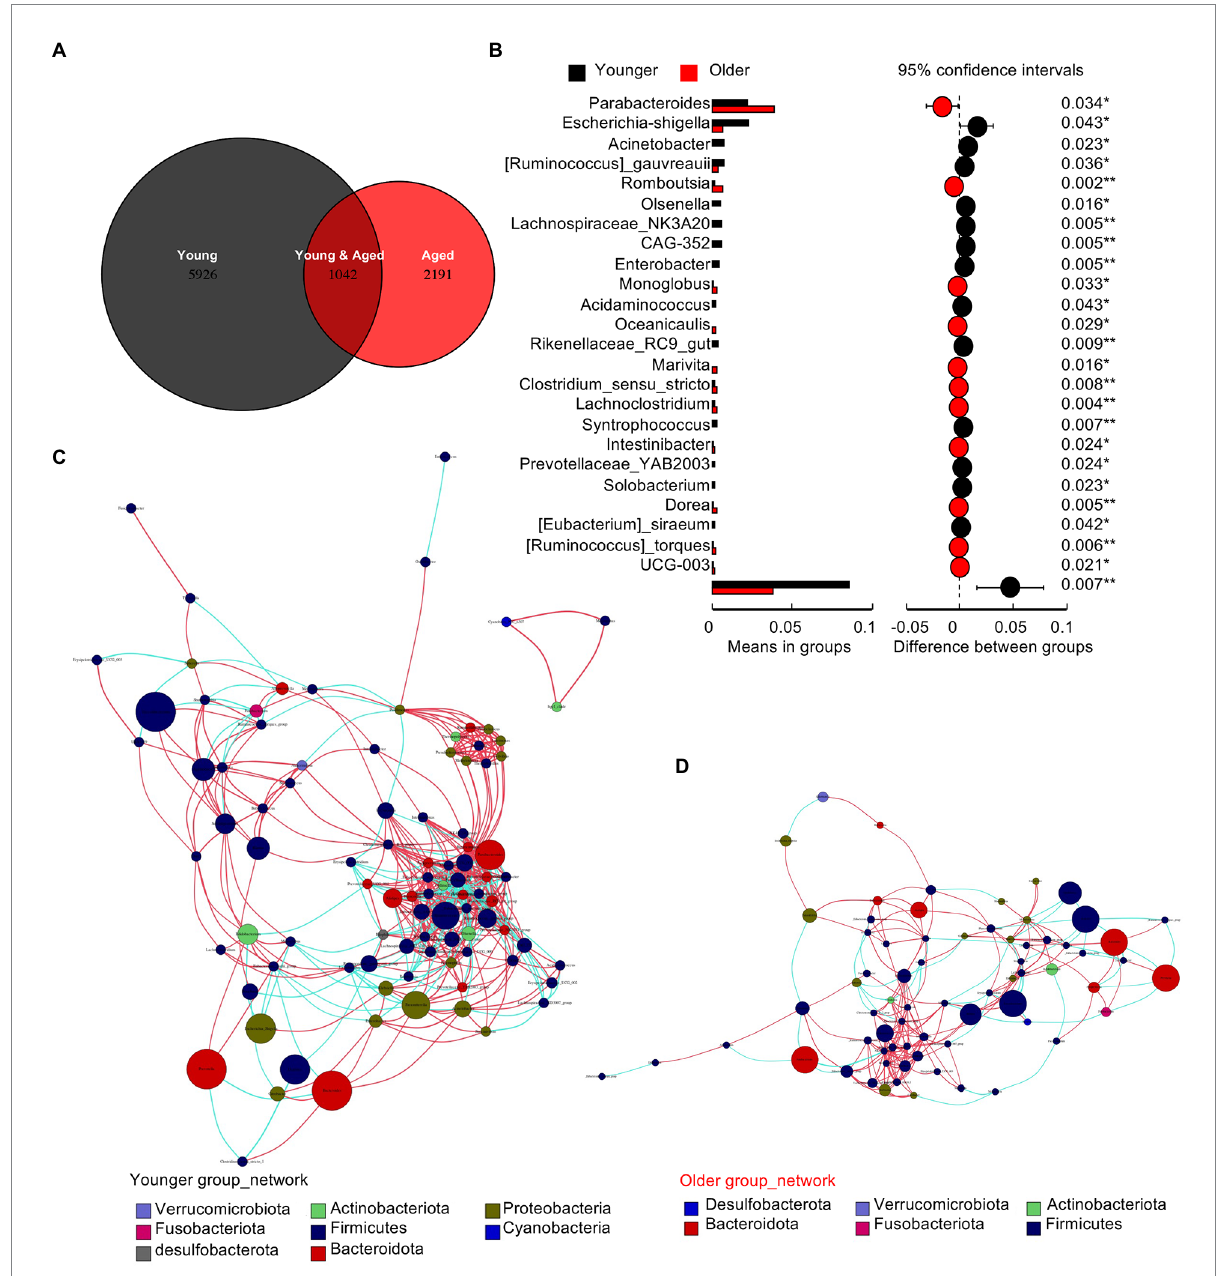
FIGURE 2 Gut microbiota of older people show the deletion of multiple types of non-dominant species. (A) Venn diagram of the two groups. (B) The t test between the two groups at the genus level. (C) Co-occurrence network diagrams of the healthy young group. (D) Co-occurrence network diagrams of the healthy older